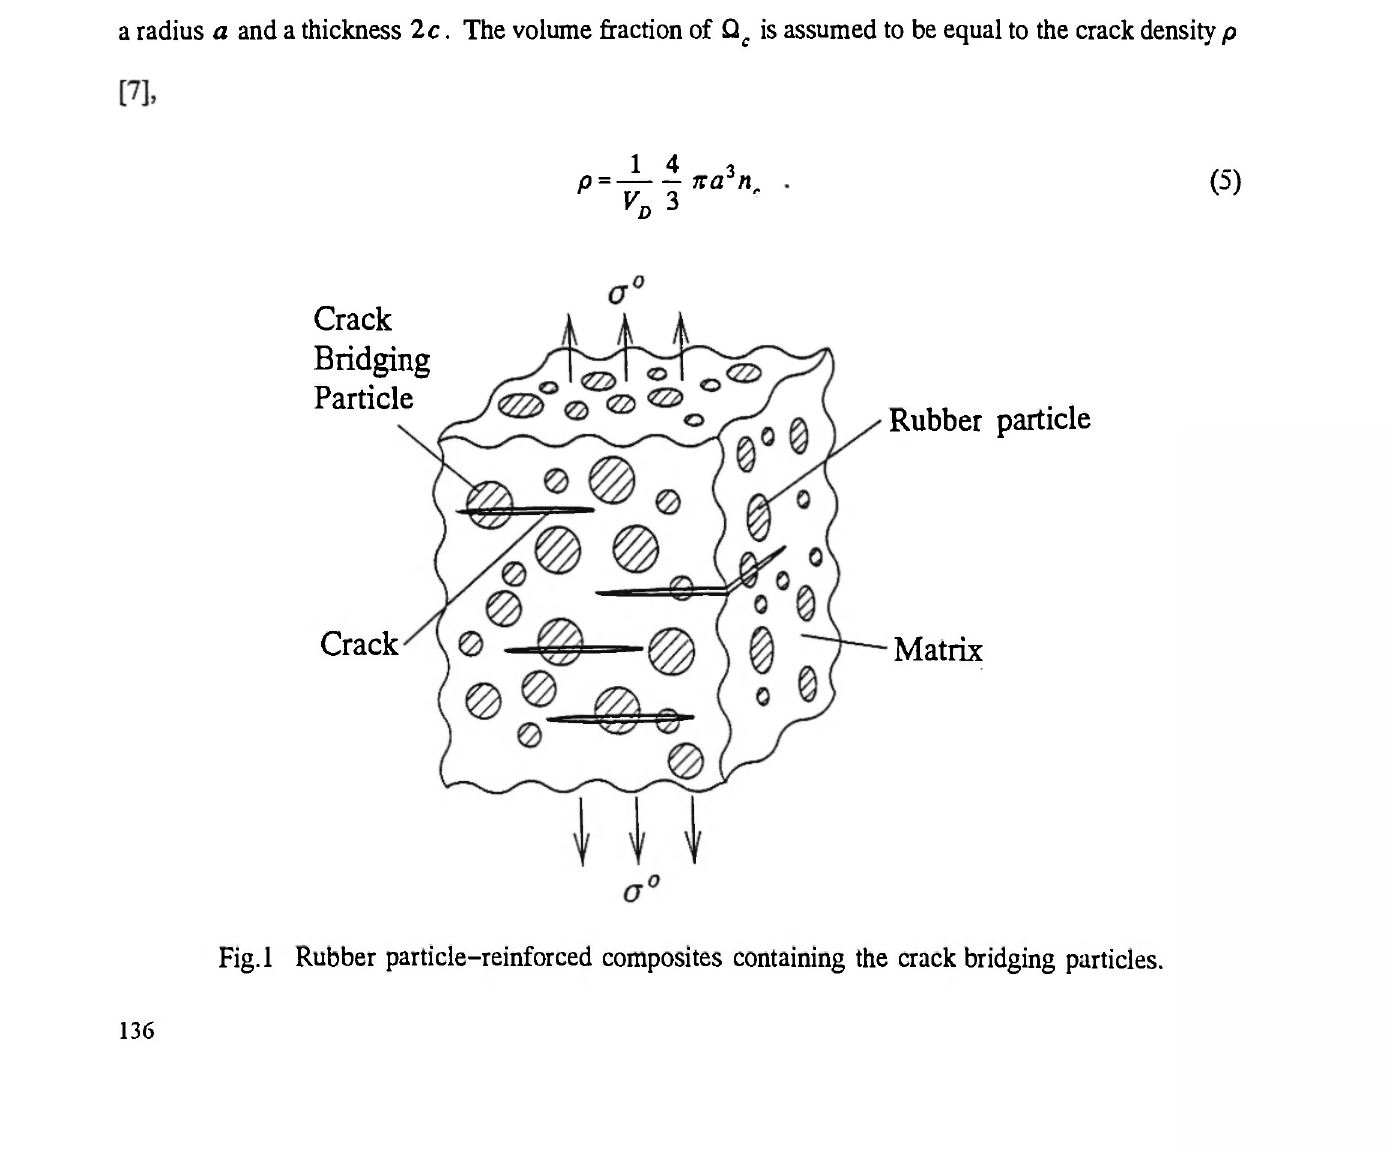
Fig.l Rubber particle-reinforced composites containing the crack bridging